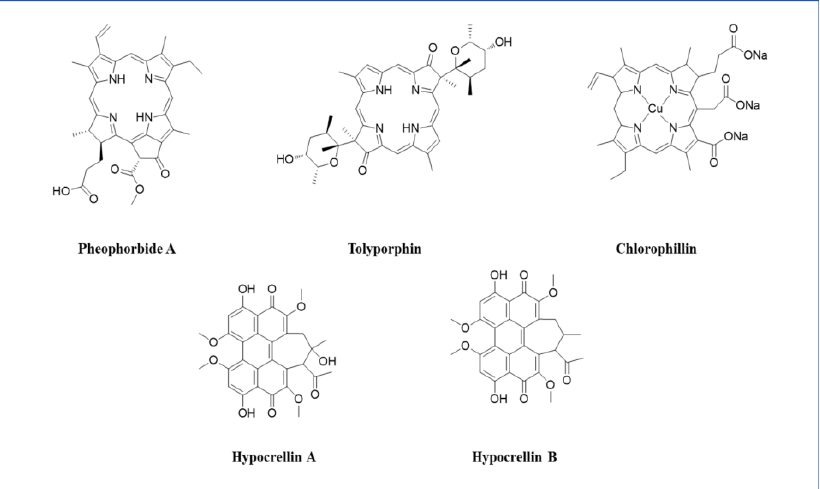
Figure 4. Chemical formulas of the most common photoactive natural PS’s discussed in the review.